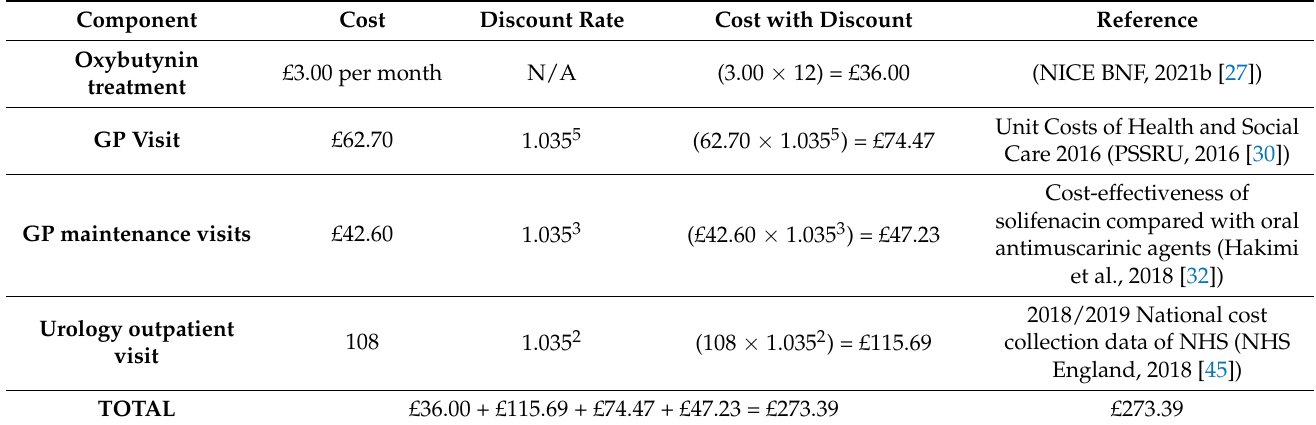
Table A3. Cost For oxybutynin.